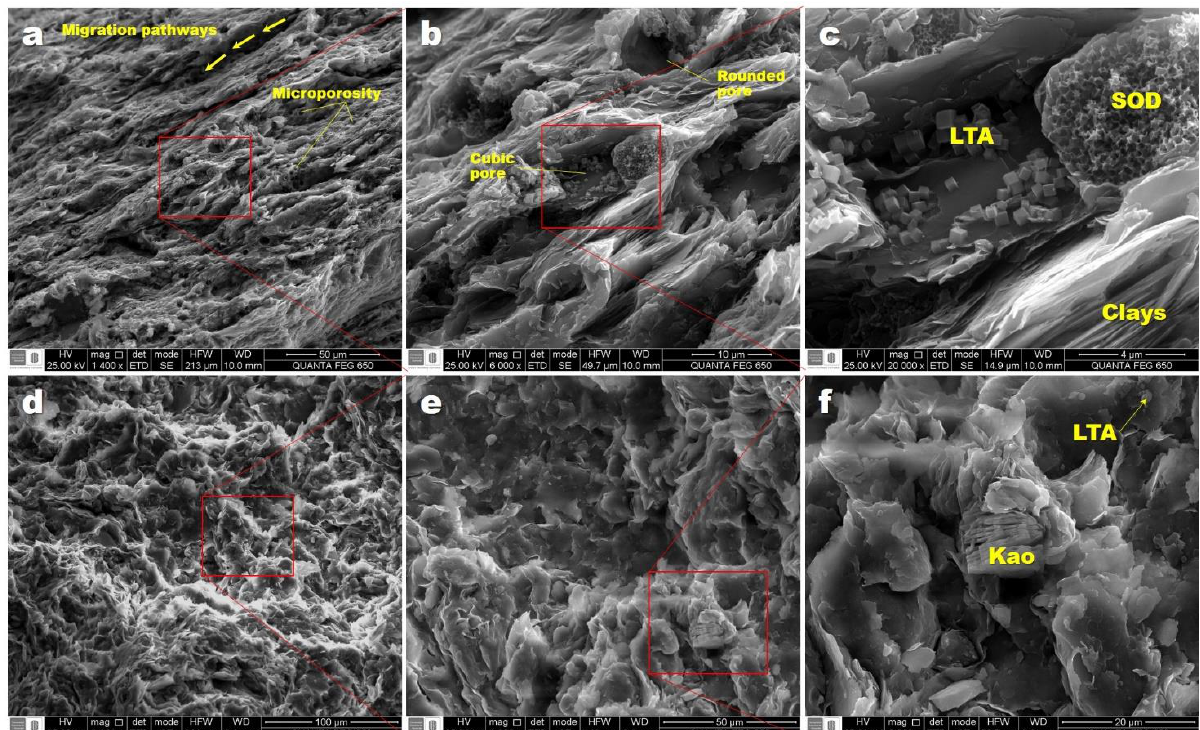
Figure 5. Secondary electron (SE) images of the ( a ) morphological features of the wavy micro-lamination, not parallel and discontinuous, fabric of the analyzed mudstone, ( b ) microporosity, ( c ) aggregates of Na–A zeolite and sodalite and clays, and ( d )–( f ) aggregates of clays of kaolinite-type in the matrix. LTA: Na-A zeolite; SOD: Sodalite; Kao: Kaolinite.